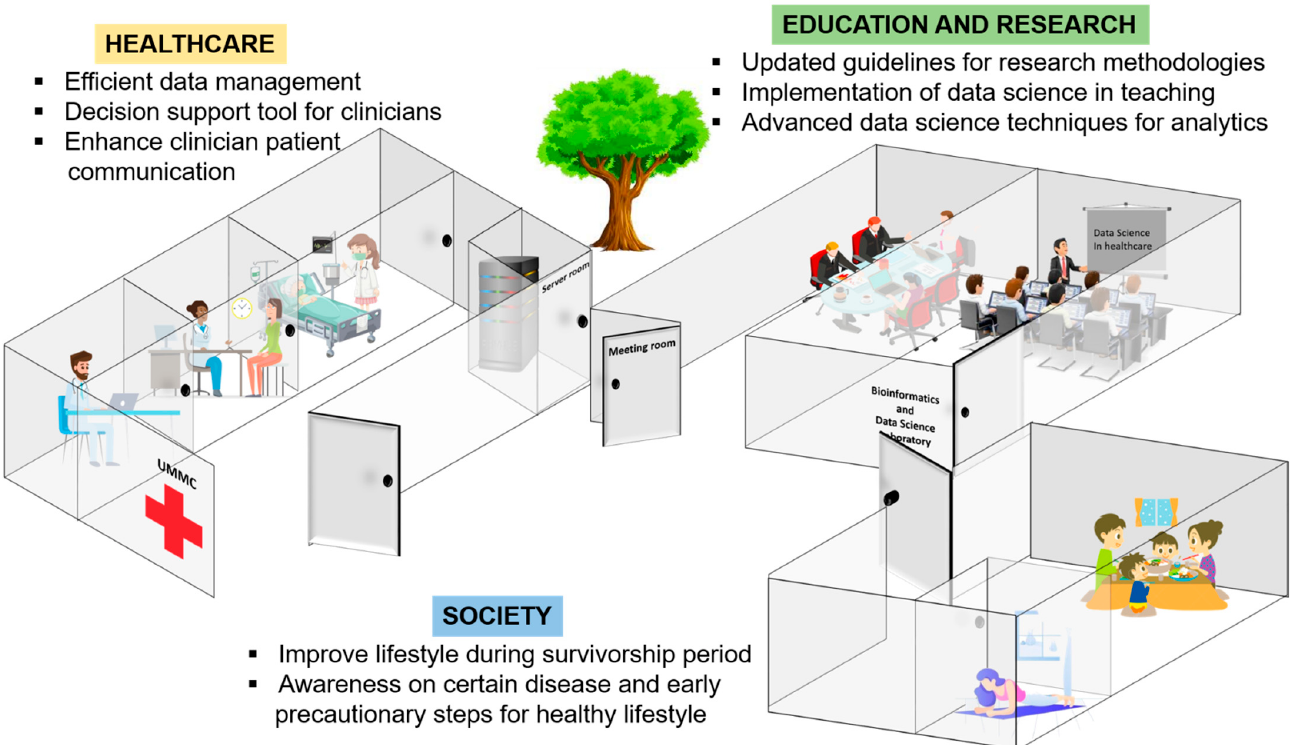
Figure 5. Significance of machine learning to healthcare, education and research and society.